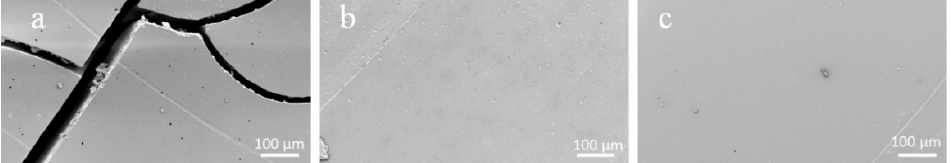
Figure 12. SEM images at 150× and 2.5 kV of ( a ) p(ISDGMA/TEGDMA), ( b ) p(ISB2GBMA/TEGDMA), and ( c ) p(BisGMA/TEGDMA) after buffer immersion for 7 days at 37 °C.